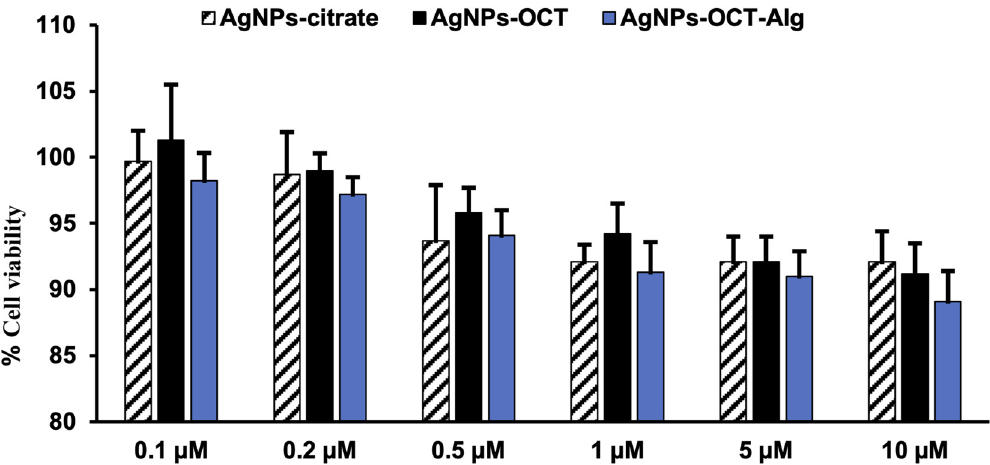
Figure 4: E ff ects of di ff erent AgNP formulations on MCF - 7 cell proliferation after treatment with di ff erent concentrations ( 0.1 – 5 μ M ) of AgNP formulations. The results are representative ( mean ± standard error of the mean ) of triplicate experiments; data without an asterisk di ff er, * p < 0.05 versus untreated cells ( control cells ) . All formulations showed no toxicity, while concentrations of 1 – 5 µM showed signi fi cant inhibition of cell proliferation ( p < 0.05 ) .